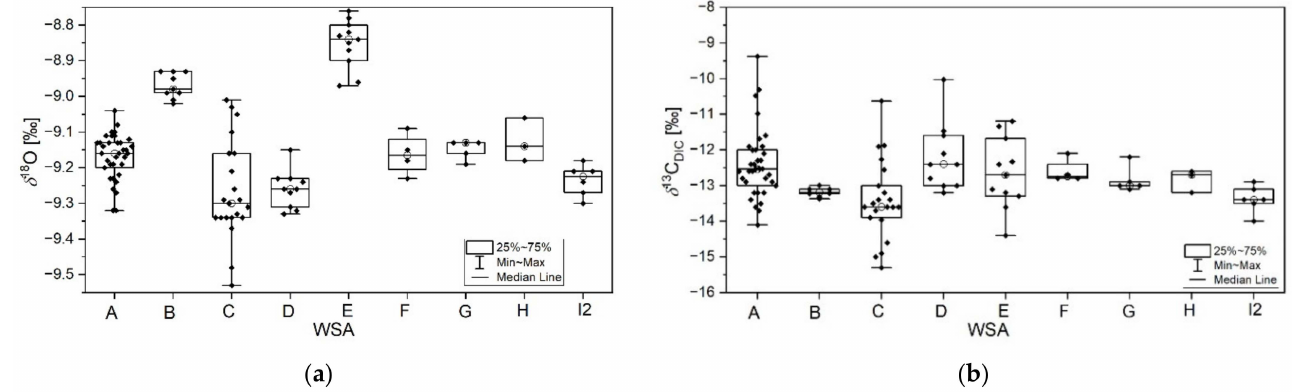
Figure 5. Distribution of ( a ) δ 18 O and ( b ) δ 13 C DIC regarding different WSA for the whole system (N = 97). For the explanation of the abbreviations, see Section